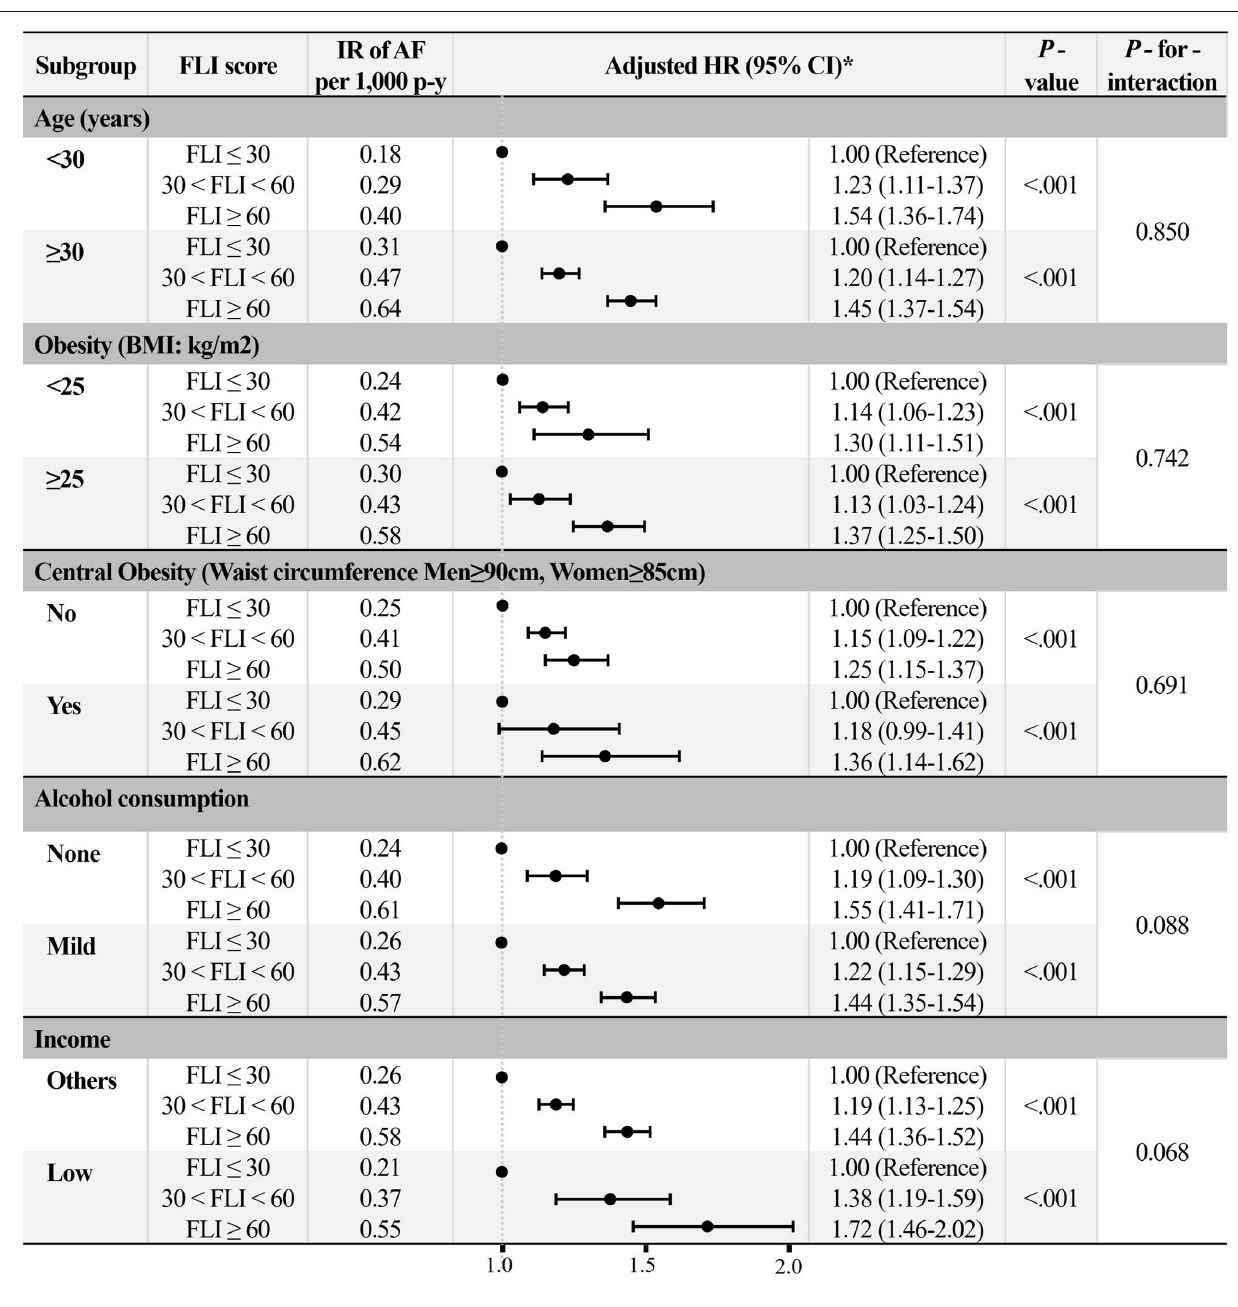
easily curable, significantly affects patients’ quality of life, and is